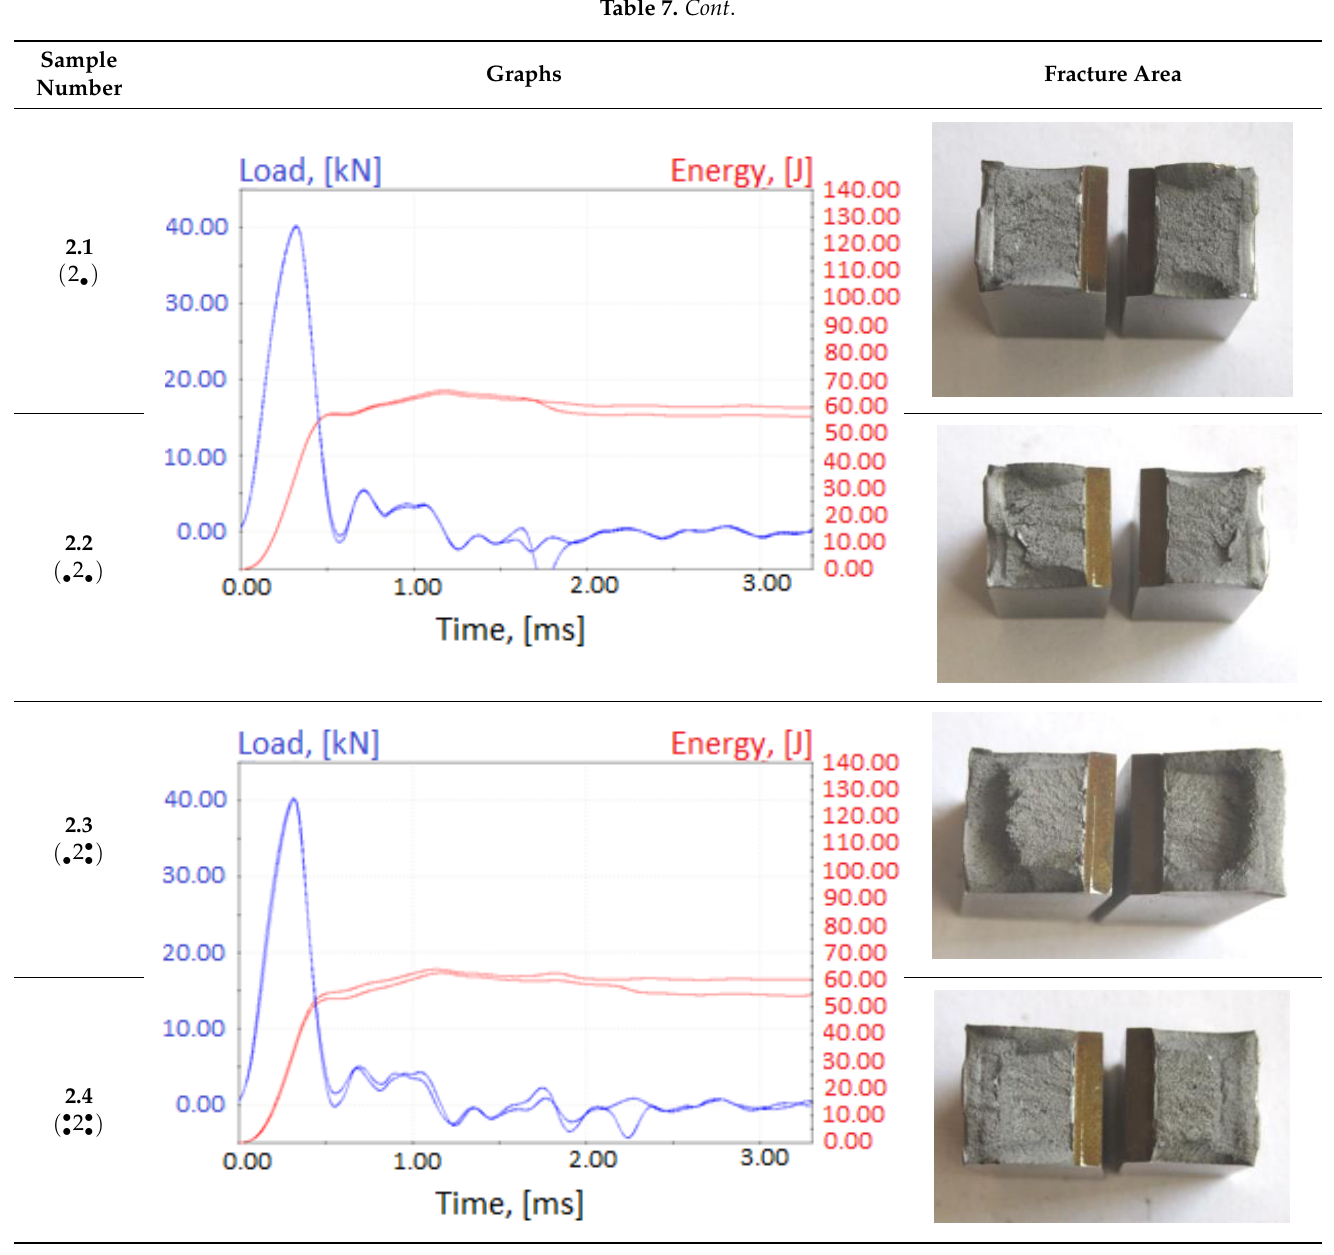
10 of 17 Table 7. Test results: fracture pictures and graphs of exerted energy and load (material after heat treatment). Sample Number